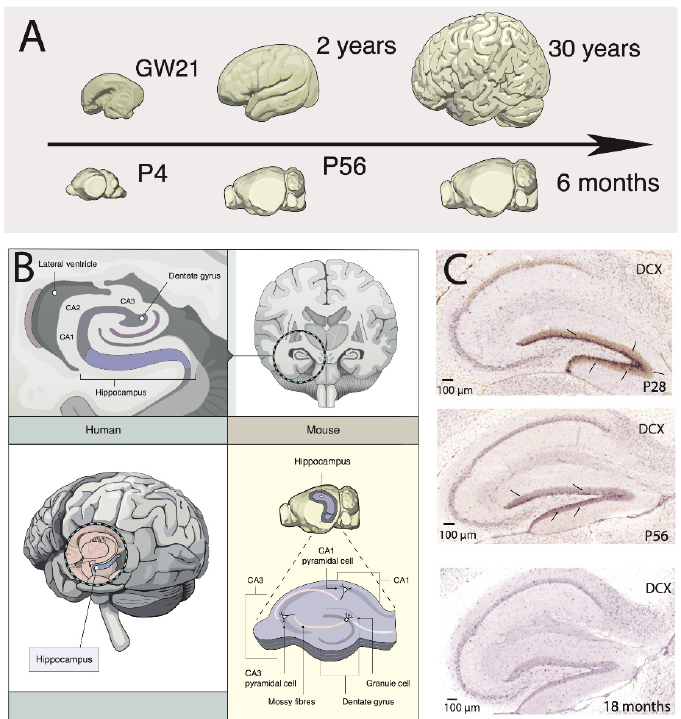
Figure 4. ( A ) We identified corresponding ages between humans (top panel) and in mice from abrupt transformations in behavior, anatomy, and transcription [37,51]. According to these data, a 2-year-old human corresponds to a mouse on postnatal day 56. A 30-year-old human is equivalent to a 6-month-old mouse. Aligning ages enables identifying whether the gradual decline in DCX expression shares a similar temporal pattern in humans and in mice. According to these data, DCX is difficult to detect after post-natal day 56, which corresponds to 2 years of age in humans. ( B ) Schematics illustrate the location and spatial organization of the human and murine hippocampus. Hippocampal neurogenesis extends postnatally in the dentate gyrus. ( C ) Images of doublecortin (DXC) mRNA expression, used as a marker of immature neurons, show that DCX expressions (arrows) in the dentate gyrus gradually decline with age in mice. Expression levels are relatively high at postnatal day (PD) 28 but steadily decrease from postnatal day 28 to 18 months of age. By 18 months of age, DCX expression is difficult to detect in the murine dentate gyrus. ISH images are from the used in situ hybridization Allen Brain Institute (http://mouse.brain-map.org, accessed on 28 July 2021). A baseline to compare the biology of humans and chimpanzees makes us better equipped to assess which biological programs are conserved and which have evolved in the human lineage. It also enables predicting temporal variation in biological programs in humans from model systems. We previously predicted a temporal pattern of variation in hippocampal neurogenesis in mice to predict the temporal pattern in humans [35]. We considered temporal variation in the relative number of DCX+ cells in the hippocampus at different postnatal ages in mice and non-human primates to predict the temporal pat- tern of hippocampal neurogenesis in humans (Figure 5). If the temporal pattern of hippo- campal neurogenesis is conserved across rodents to humans, hippocampal neurogenesis should decline sharply during childhood to hard-to-detect levels. These findings align with reports by Sorrells and colleagues [33,78] (Figure 5). We have yet to align other forms of brain plasticity from model systems to humans. It is unclear whether transient expres- sion in DCX spans similar timescales in humans and model systems and whether the rel- ative number of DCX positive cells captures neuron production or neuron immaturity.